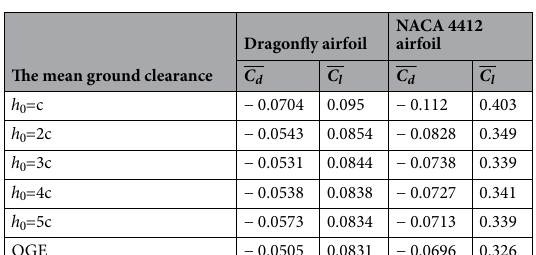
The mean ground